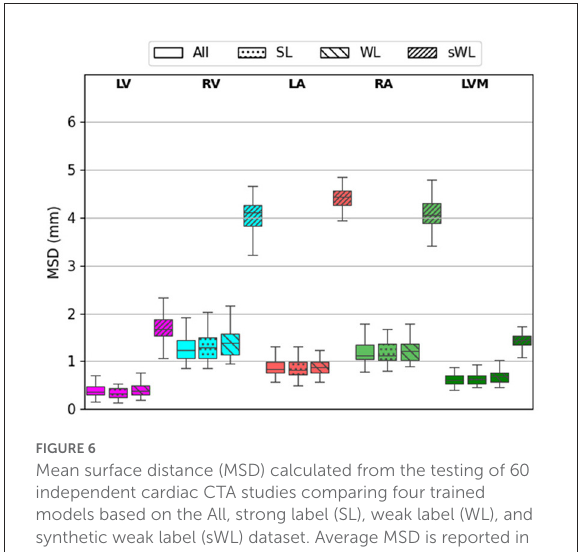
FIGURE6 Mean surface distance (MSD) calculated from the testing of 60 independent cardiac CTA studies comparing four trained models based on the All, strong label (SL), weak label (WL), and synthetic weak label (sWL) dataset. Average MSD is reported in mm for each structure including left and right ventricles (LV, RV), left and right atria (LA, RA), and LV myocardium